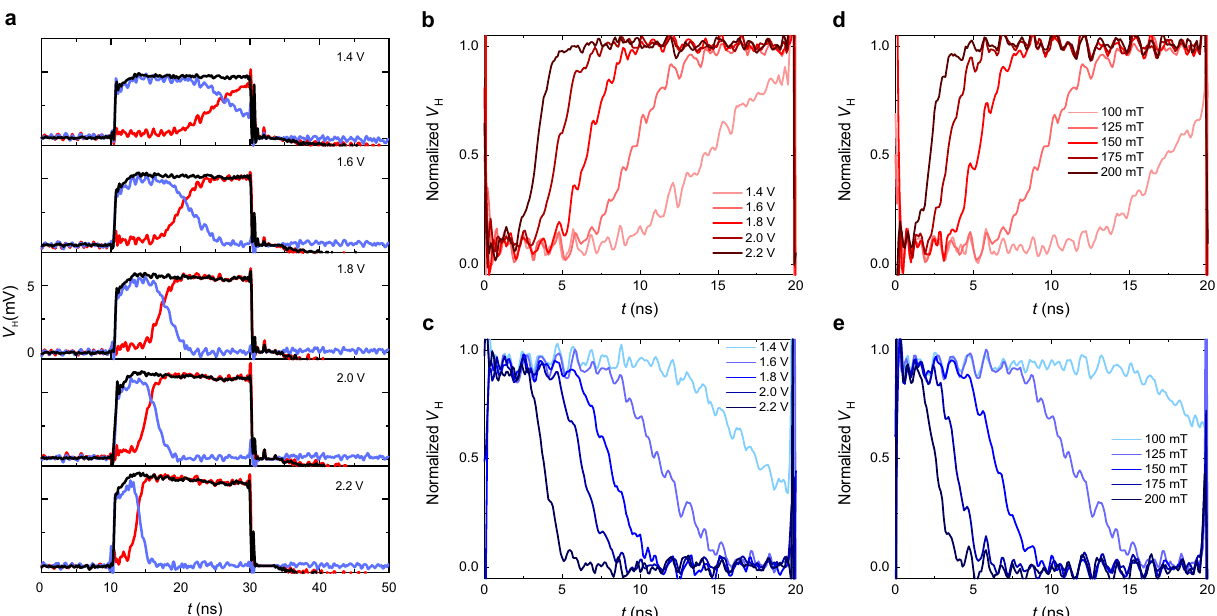
Fig. 2 Switching dynamics of ferrimagnetic dots. a Reference (in black) and switching traces of Pt/GdFeCo dots for 20-ns-long voltage pulses of increasing amplitude, showing up-down (blue lines) and down-up (red lines) reversals. The curves are averages of 1000 events. The in-plane magnetic fi eld is 125 mT. b , c Normalized down-up and up-down switching traces at different pulse amplitudes corresponding to the traces in a . The current density in the Pt layer corresponding to a pulse amplitude of 1.4 V is ≈ 5.2 × 10 11 A m − 2 . d , e Normalized down-up and up-down switching traces at different in- plane fi elds, for pulses with 1.6 V amplitude. In all the measurements the current was positive, whereas the fi eld was positive (negative) in c , e ( b , d ).